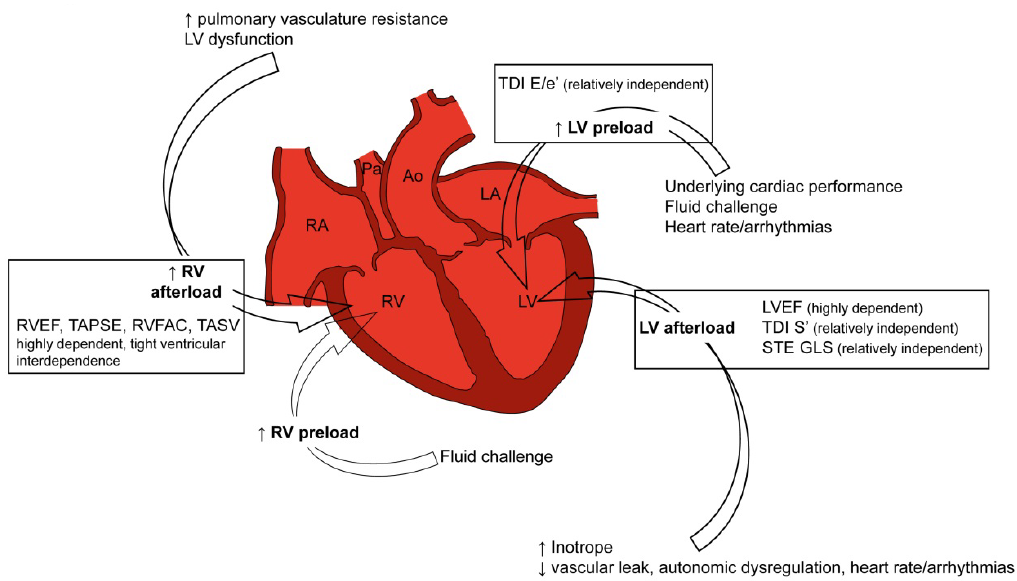
Figure 1. Diagnostic challenges in septic cardiomyopathy are a consequence of its complex patho- physiology. Recent advances in cardiac imaging paradoxically increased the uncertainty on how to define sepsis-induced cardiomyopathy. Underlying myocardial dysfunction, heart rate and the need of acute interventions (i.e., fluid challenge and inotrope use) add further layer of complexity. These issues highlight the importance of a dynamic assessment of cardiac performance over time, not limited to echocardiographic findings but also considering the cardiac performance.